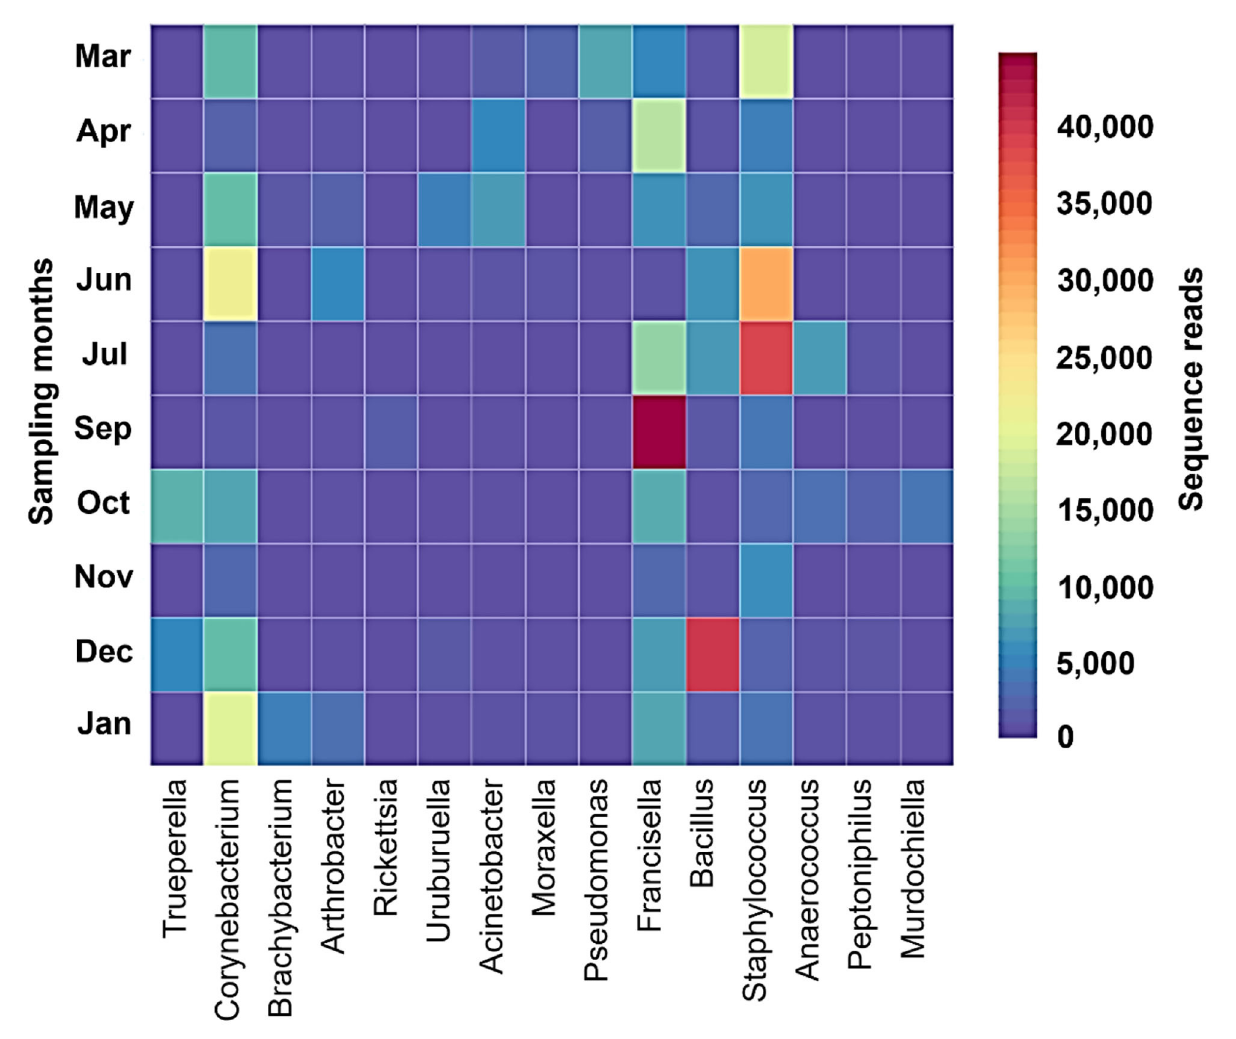
FIGURE 4 | Matrix plot shows dominant genera in different months in H. dromedarii partially engorged female